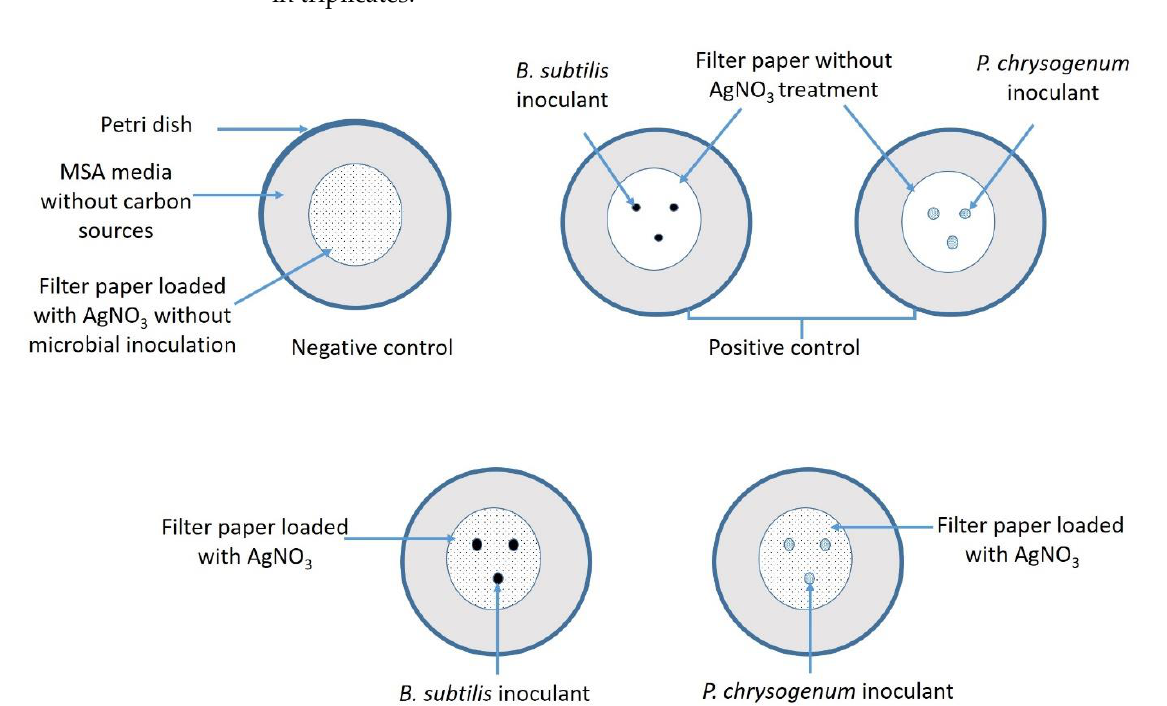
Figure 6. Outline showed the design of the experiment to evaluate the efficacy of AgNO 3 on microbial growth and paper quality.